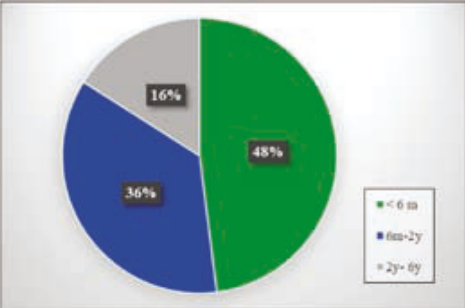
Fig. 6. Age wise distribution of dermato-